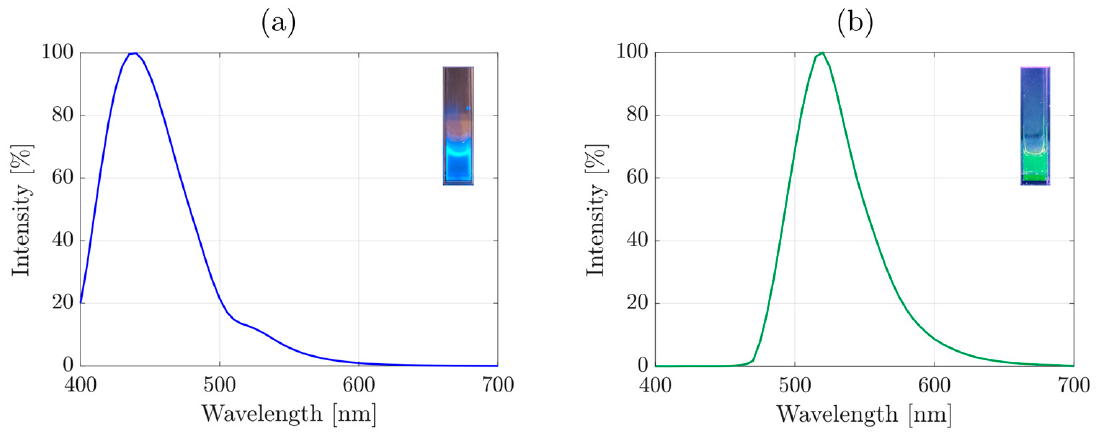
Figure 3. Optical fluorescence (PL) spectra for CQDs ( a ) and Rh-CQDs NPs ( b ) with excitation wavelengths of 390 and 490 nm, respectively. In the inserts, photographs of corresponding samples in a vial irradiated with UV light are presented.